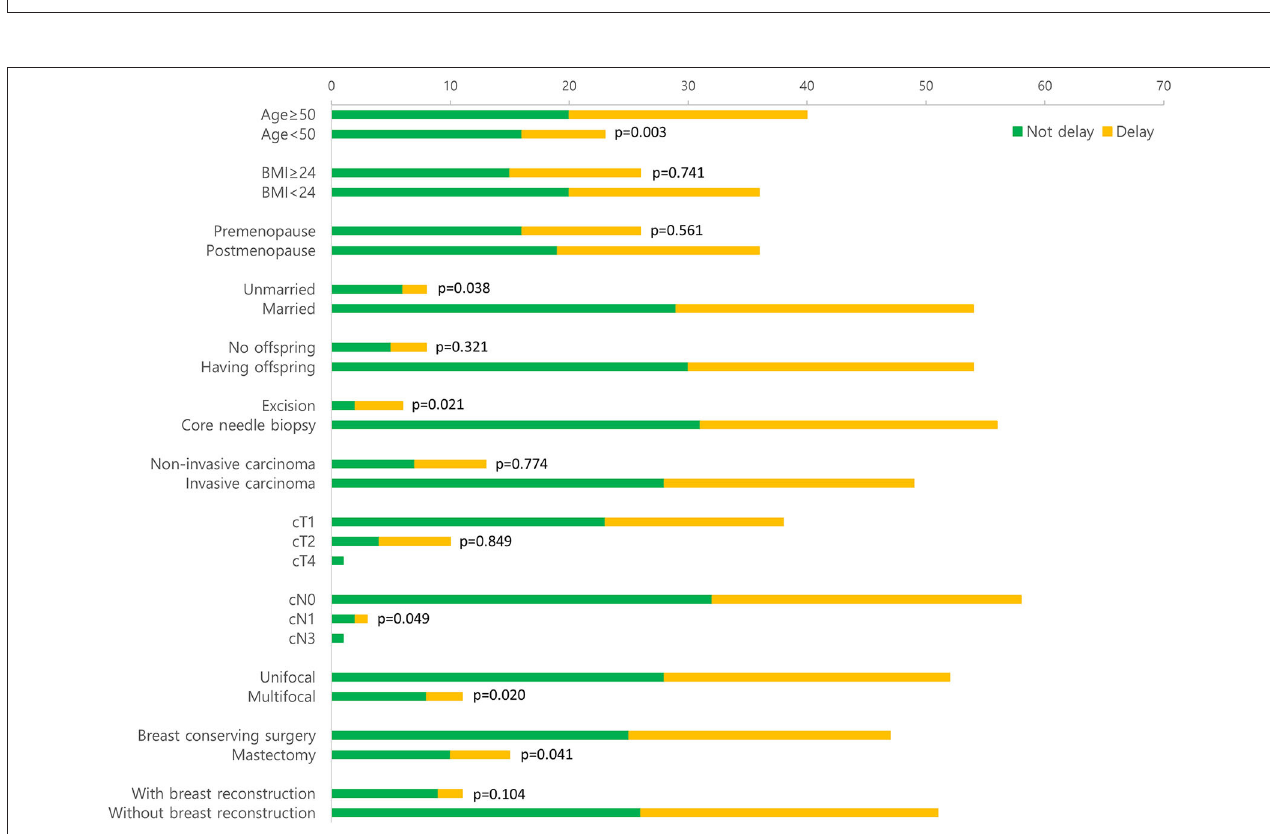
FIGURE 2 | Comparison of personal and clinicopathological factors between the delaying and non-delaying surgery groups.